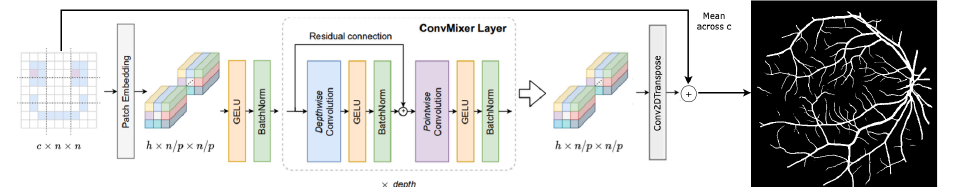
Figure 3. Original ConvMixer architecture plus the final modification to face segmentation problems. Adapted with permission from Ref. [20]. 2021, Asher